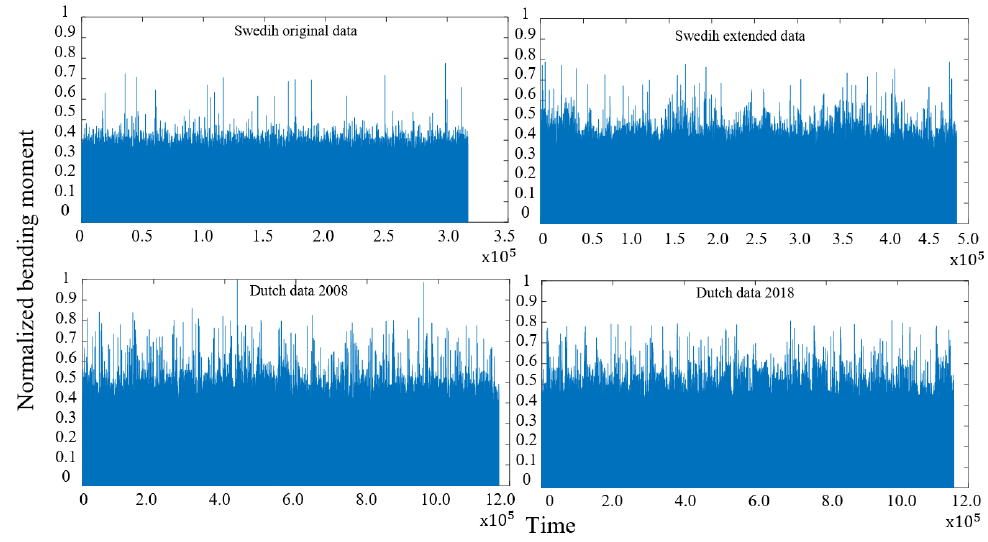
Figure 15. Bending moment history generated by the different databases normalized to the maximum obtained moment, for a 10 m simply supported